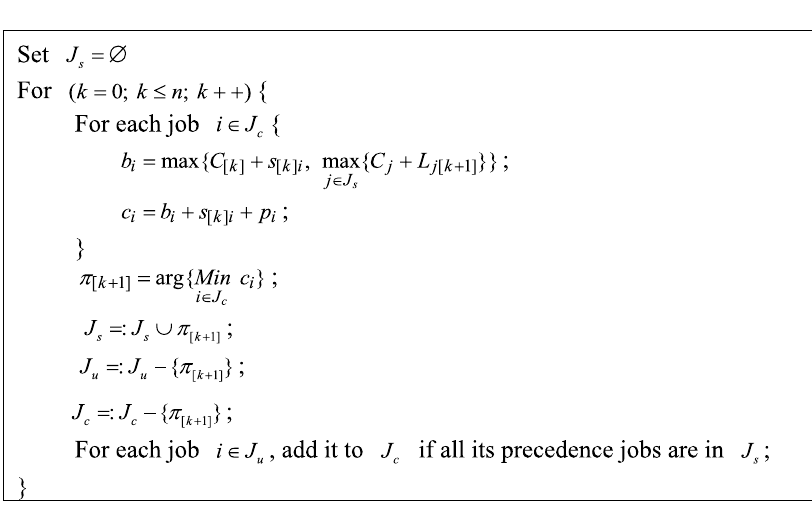
Figure 2. The detailed procedure of constructing the initial